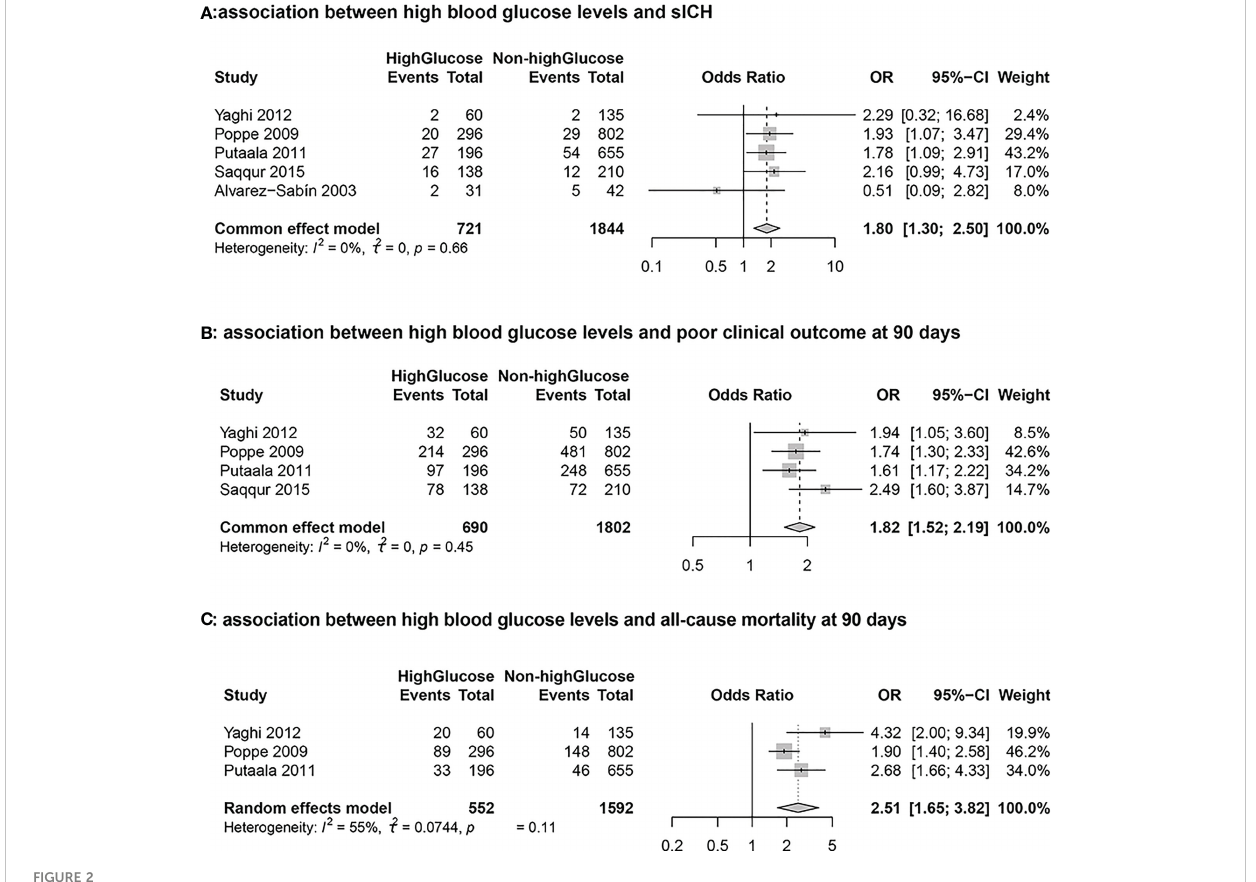
Glucose, OR: 2.51, 95% CI:1.65-3.82, I2 = 55%; Figure 2C). The results from sensitivity analyses, which excluded one data set at a time, were consistent. (OR: 2.51 95%CI:1.65-3.82; Figure 3C).